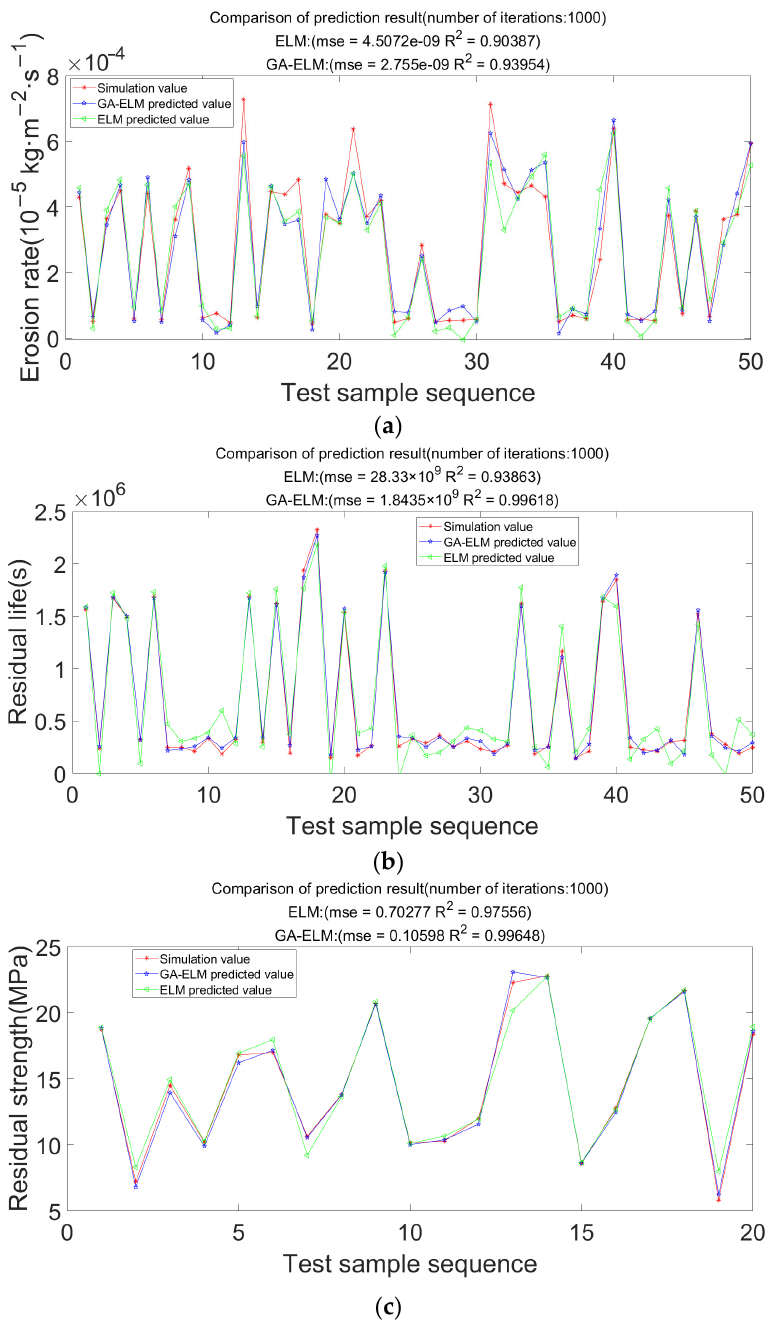
Figure 19. Comparison of the accuracy of the two prediction models. ( a ) Schematic diagram of erosion rate prediction; ( b ) Schematic diagram of residual life prediction; ( c ) Schematic diagram of residual strength prediction.